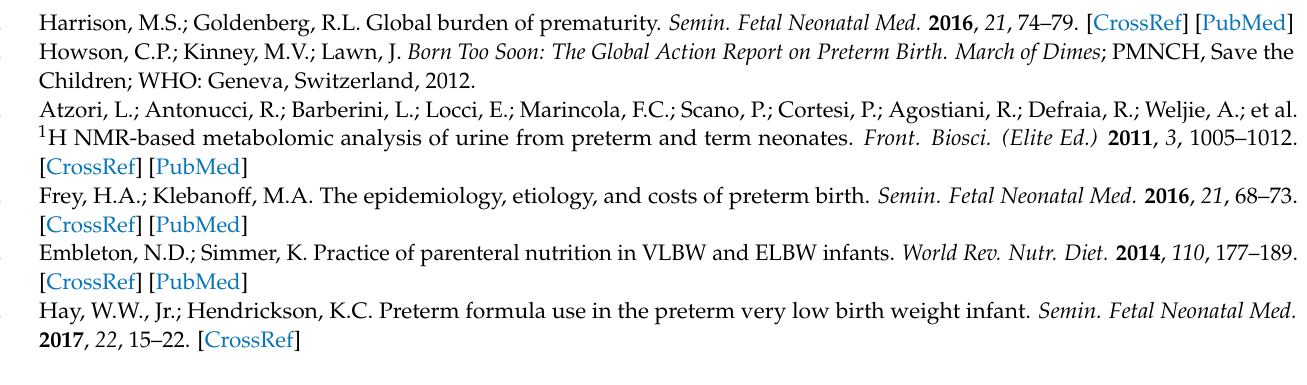
model; Figure S4: Loading plot (loadings vs. time) of the first mode (time) in the PARAFAC-2 model; Figure S5: Loading plot (loadings vs. chemical shifts) of the second mode (spectra) in the PARAFAC-2 model; Table S1. Detailed results from the pathway analysis; Table S2. ANOVA results of comorbidities for each NT group Table S3. Characteristics of the PN used in the studied preterm newborns; Table S4. Characteristics of the EN used in the studied preterm